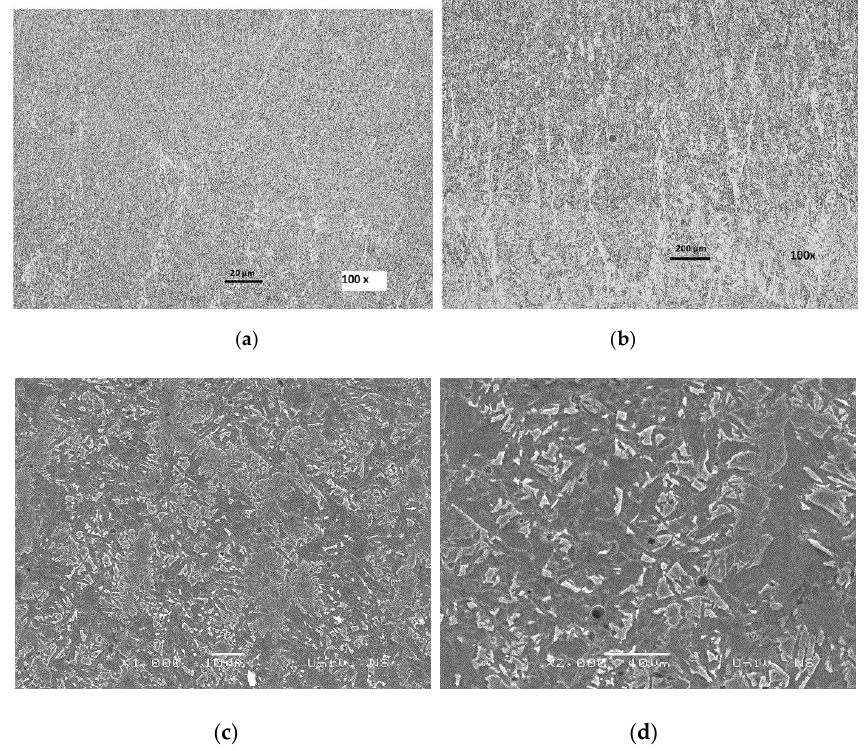
Figure 13. OM ( a , b ) and SEM ( c , d ) microstructure of WM created by electrode No.2.2.